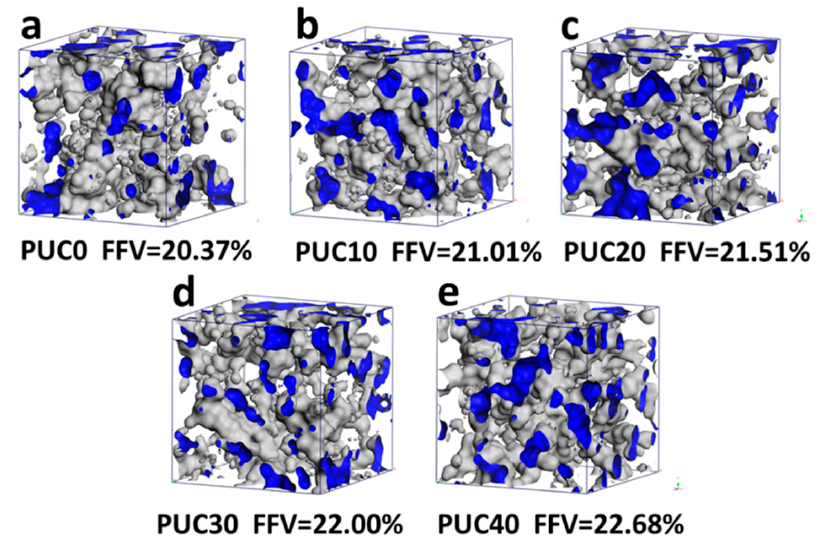
Figure 8. Simulated free volume morphologies of ( a ) PUC0, ( b ) PUC10, ( c ) PUC20, ( d ) PUC30 and ( e ) PUC40. Grey areas represent the free volume.